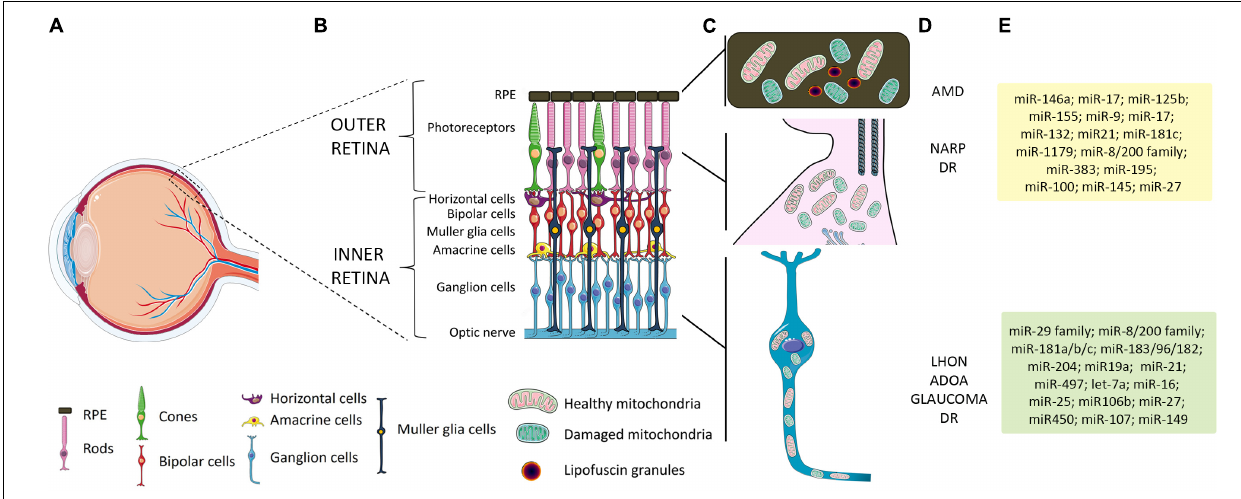
FIGURE 1 | Schematic representation of retinal layers, mitochondrial distribution, and related retinal pathologies and miRNAs. (A) Schematic representation of the human eye. The box identifies the position of the retinal layers in the posterior part of the eye. (B) Magnification of the retina and retinal layers in healthy conditions. (C) A peculiar distribution of mitochondria is graphically represented: in RPE, which overlays the PRs, mitochondria are located at the basal region; in PRs, a high number of mitochondria are present in the inner segment; in the inner retina, mitochondria are predominantly concentrated in the unmyelinated proximal axons of RGCs. (D) Primary or secondary defect in mitochondrial functionality in RPE and PRs has been linked to AMD, NARP, and other forms of visual loss, such as DR. Primary or secondary impairment in mitochondrial function leading to RGC degeneration is considered a major cause of retinal diseases such as LHON, ADOA, glaucoma, and DR. (E) List of miRNAs expressed in specific cell retinal layers whose function or alteration in expression has been linked to mitochondrial dysfunction and retinal diseases. Yellow box shows relevant miRNAs related to AMD and DR; green box, LHON and glaucoma-related miRNAs. RPE, retinal pigment epithelium; PRs, photoreceptors; RGCs, retinal ganglion cells; AMD, age-related macular degeneration; NARP, neuropathy, ataxia, and retinitis pigmentosa; DR, diabetic retinopathy; LHON, Leber hereditary optic neuropathy; ADOA, autosomal dominant optic